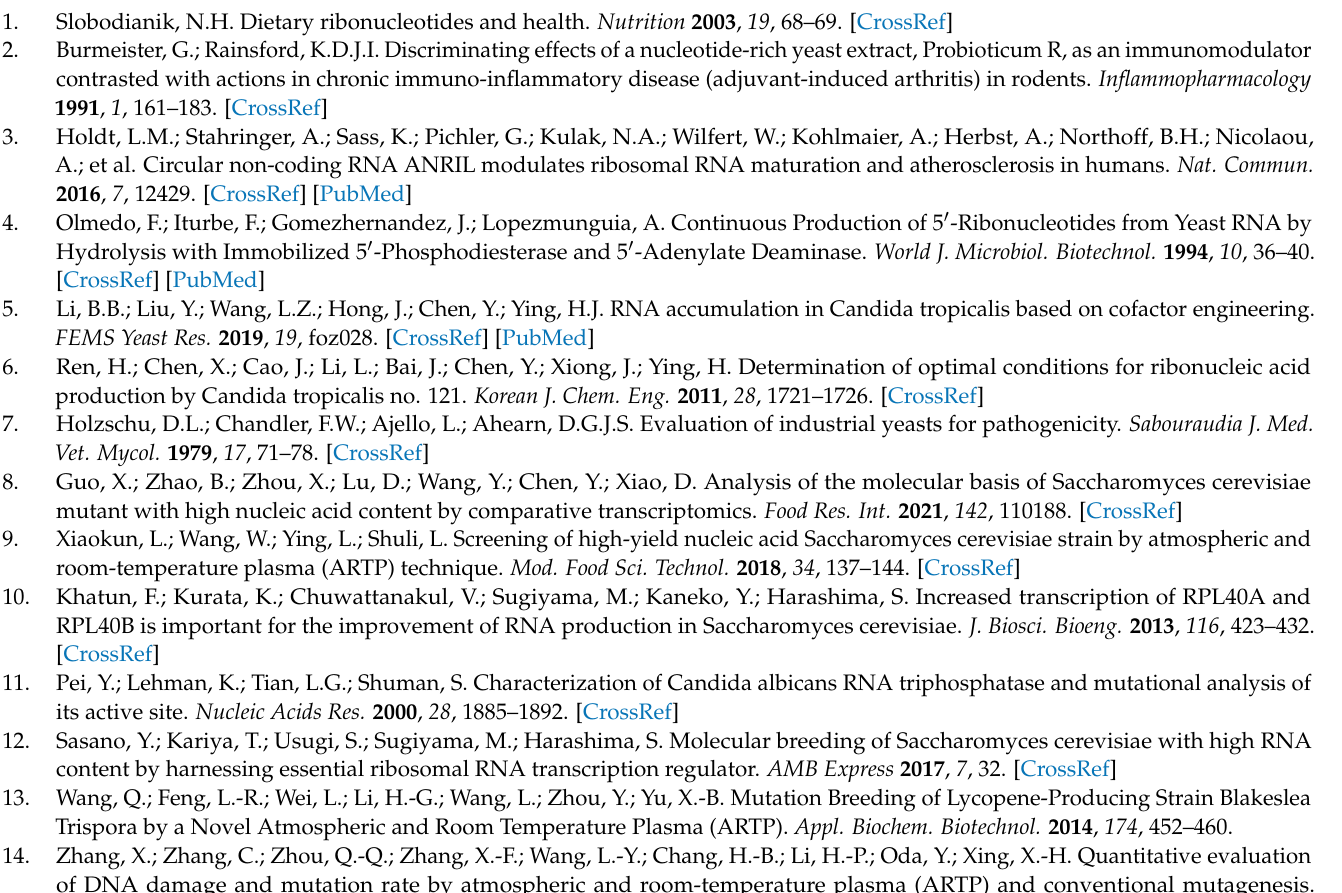
Table S1. Gas production ability of G03 and G03H8, Table S2. Statistics of SNP annotation results using S. pastorianus .CBS.1483 as the reference sequence, Table S3. Results of the PB design, Table S4. Experimental design and results of the steepest ascent path, Table S5. Experimental design and results of the central composite